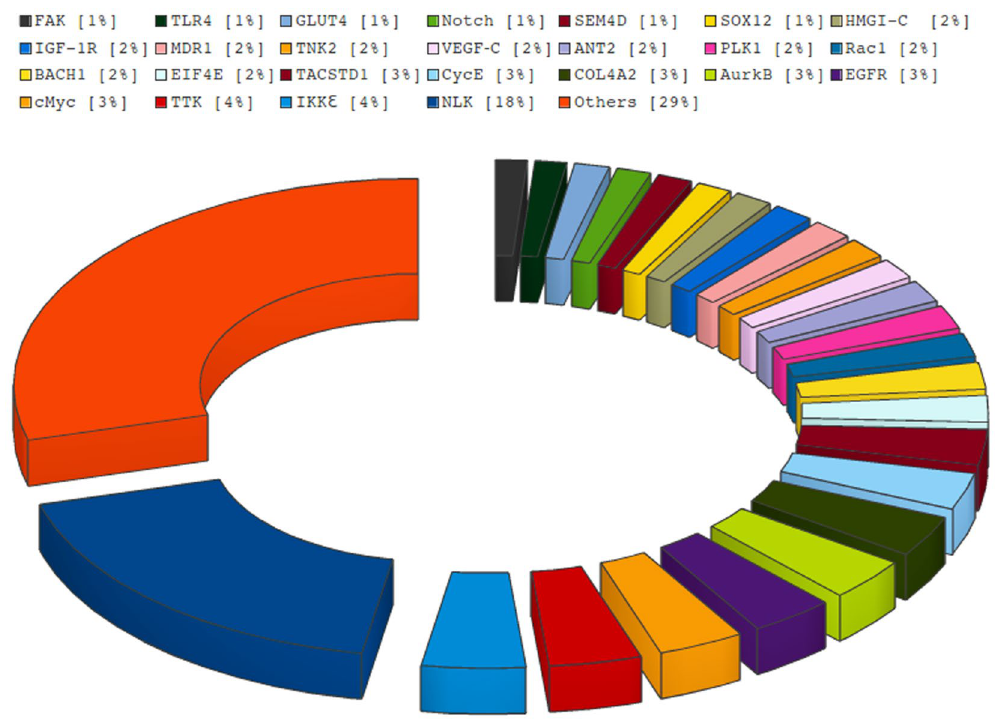
Figure 4. Oncogenes targeted by siRNA-mediated